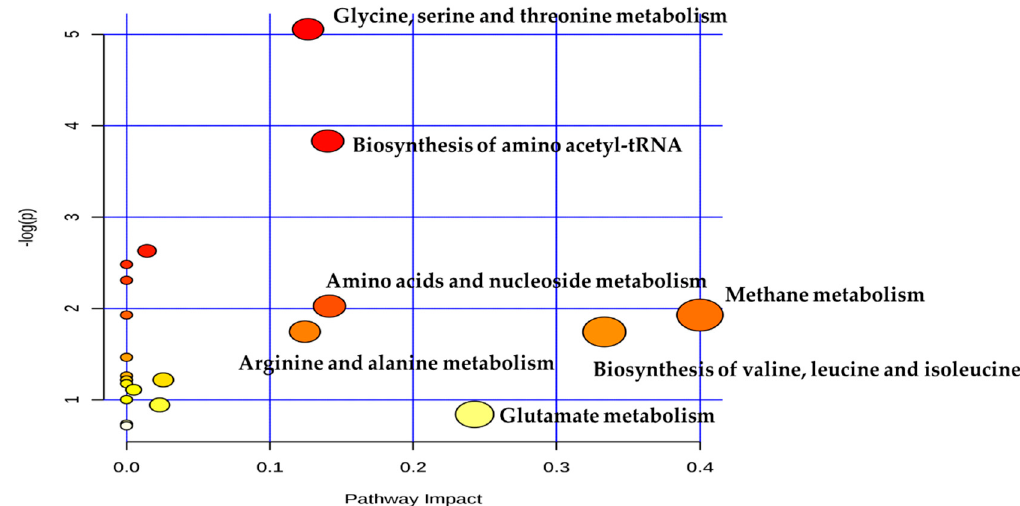
Figure 5. Metabolome view map of the differential metabolites (DMs) (VIP > 1, FDR < 0.05) identified in CON and TR groups. The larger size indicates higher pathway enrichment, and darker color indicates higher pathway impact values.